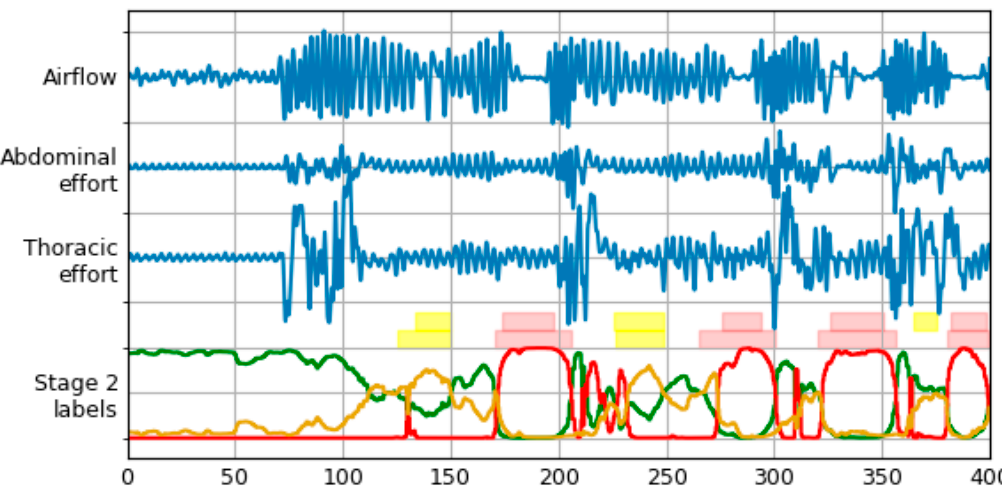
Figure 5. Signals and labels from Figure 2 with labels timeline produced by Stage 2 LSTM. Normal, apnea and hypopnea classes are represented with green, red and yellow lines, respectively. Two rows of label bars are present—top row for database (true) labels, and bottom row for final labels predicted by the model (after the postprocessing stage).